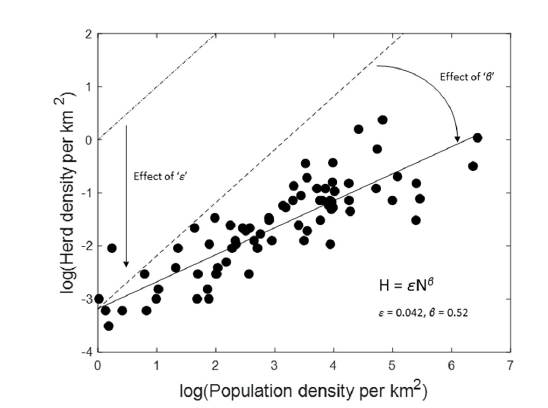
FIGURE2 Graphical interpretation of the power function for Serengeti wildebeest. The dash-dot line in the upper left corner of the plot depicts the relationship when wildebeest individuals are solitary and randomly distributed in space. The dashed line depicts the relationship expected if wildebeest formed groups of constant size of 24 (= 1/ ε ). The solid line depicts the best-fit regression line plotted through the scatterplot of observations of log (herd density) plotted against log (population density). Deviation of the solid line from the dashed line is the result of density-dependent increase in group size.